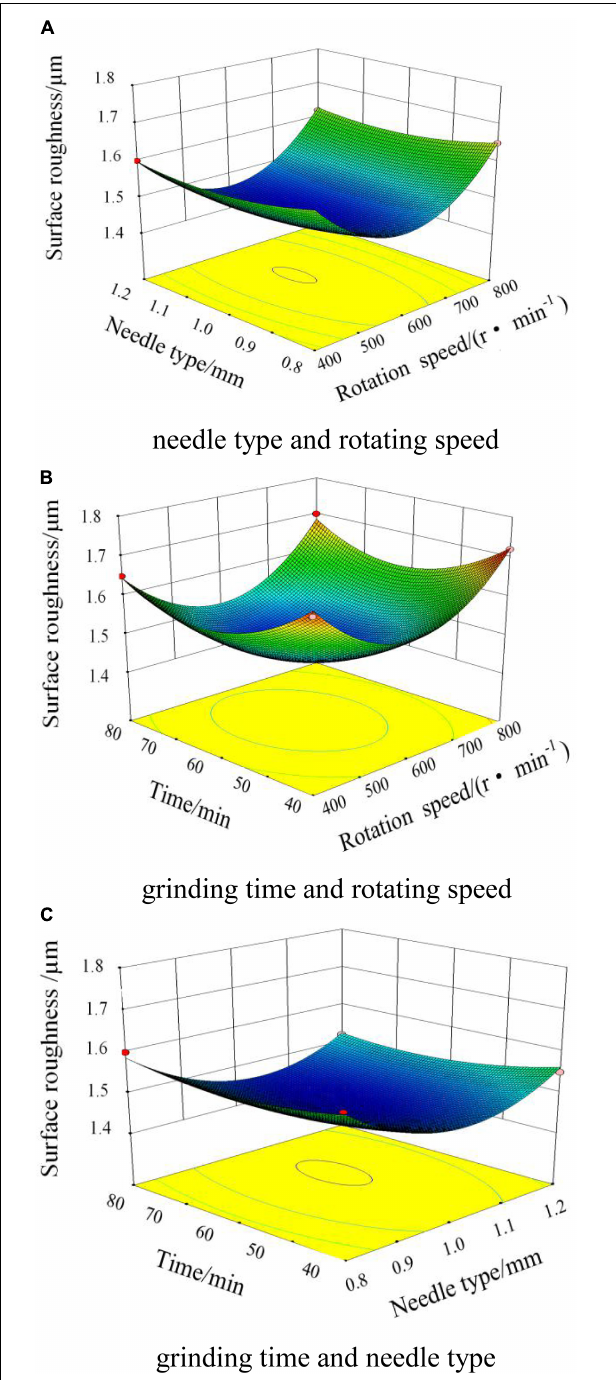
FIGURE 9 | Interaction diagram of the magnetic field. (A) Needle type and rotating speed. (B) Grinding time and rotating speed. (C) Grinding time and needle